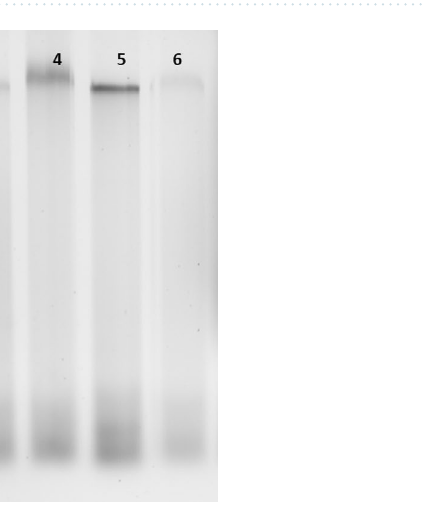
Figure 5. Stachyose does not induce DNA laddering in T. loliiformis shoots. DNA was extracted on both N. benthamiana and T. loliiformis shoots treated with stachyose at 36 h and 48 h. T. loliiformis shoots were also treated with 20 mM Potassium Oxalate (KOX) known to induce DNA laddering. 20 ng of the DNA was run on a 1% agarose gel. N. benthamiana samples treated with stachyose were positive controls. Lane 1/2: 3.2 mg/ml Stachyose treated Nicotiana benthamiana (36 h/48 h); Lane 3/4: 20 mM KOX treated T. loliiformis (36 h/48 h); Lane 5/6: 3.2 mg/ml Stachyose treated T. loliiformis (36 h/48